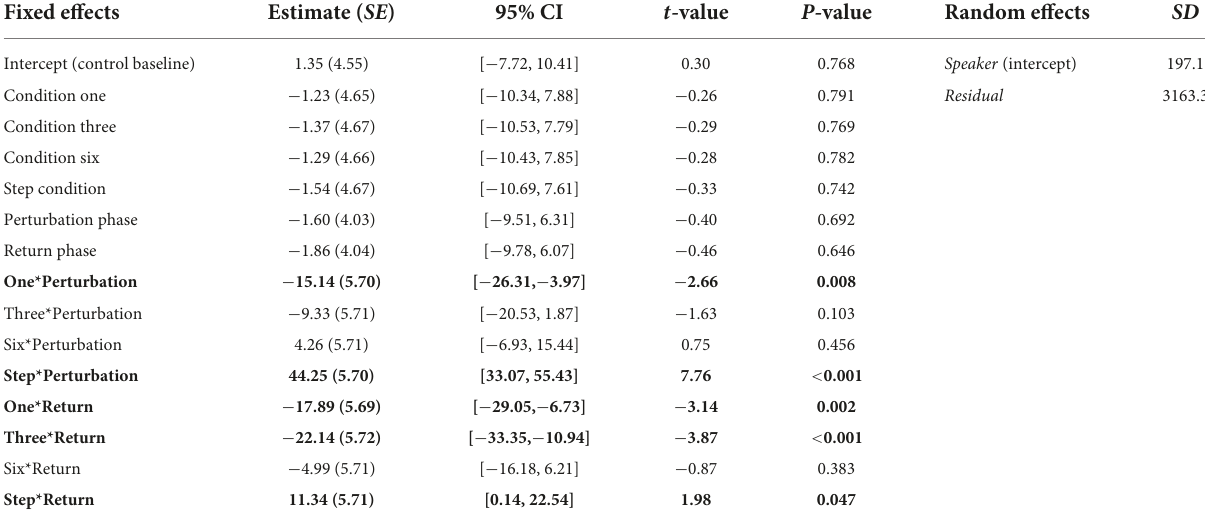
TABLE 4 Coefficients from the Best-Fit Model used to predict speakers’ normalized F2 values during Experiment